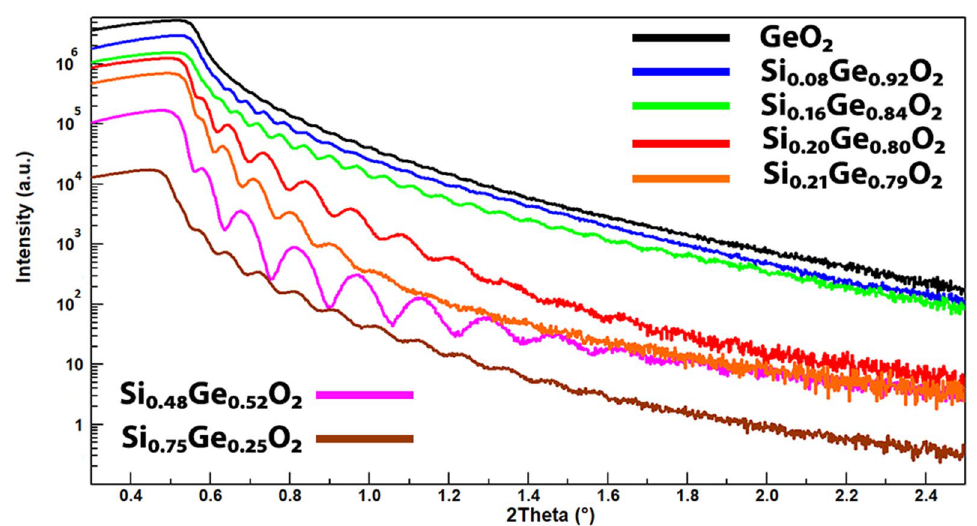
Figure 4. X-ray reflectivity (XRR) curves of Si x Ge 1 − x O 2 thin films grown on Y-cut quartz substrates, from which the film thickness and electron density are extracted. They show that the thicknesses of the thin films decrease with increasing silicon content, as a result of the displacement of the material on to the columns. The electron density change of the series can also be easily observed from the shift of the critical angles. The thickness is estimated to be 151 nm, 120 nm, 106 nm, 65 nm, 74 nm, 47 nm and 77 nm, for x = 0, 0.08, 0.16, 0.20, 0.21, 0.48 and 0.75,